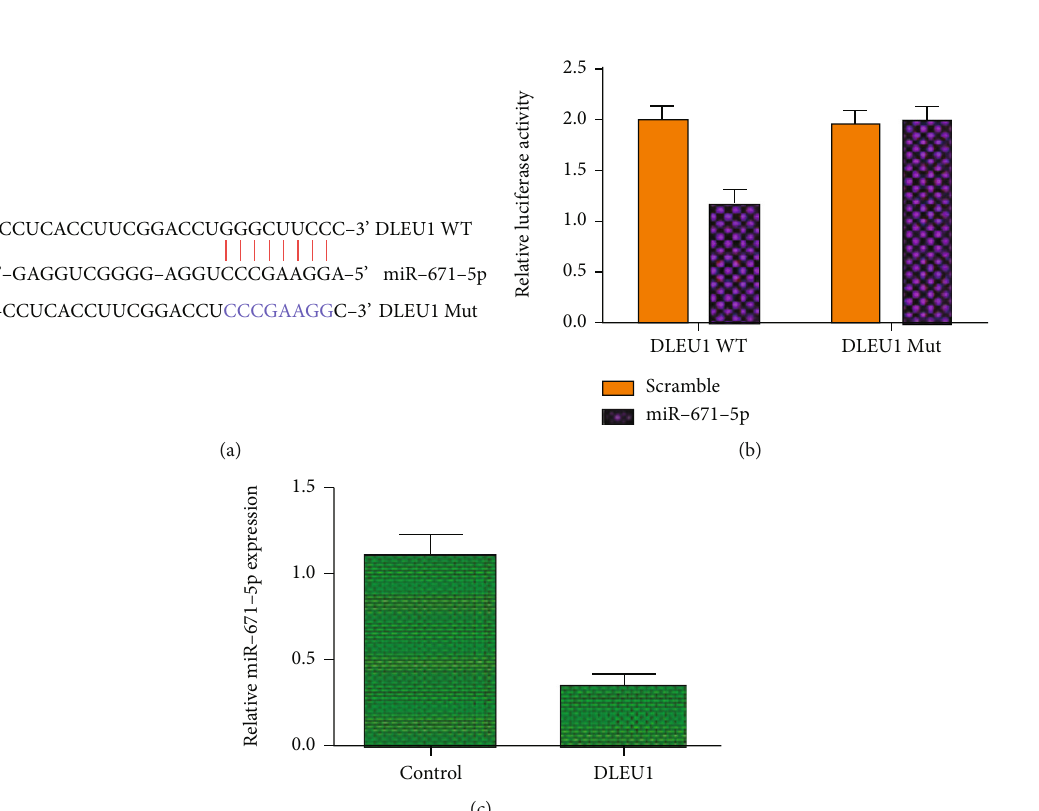
Figure 7: Elevated expression of miR-671-5p suppressed chondrocyte viability, degradation of ECM, and in fl ammation mediator secretion. (a) The expression of miR-671-5p was measured by qRT-PCR analysis. (b) Ectopic expression of miR-671-5p inhibited cell viability in the chondrocytes using CCK-8 assay. (c) Elevated expression of miR-671-5p enhanced collagen II expression in the chondrocytes. (d) The expression of aggrecan was detected by qRT-PCR assay. (e) Overexpression of miR-671-5p suppressed ADAMTS-5 expression in the chondrocytes. (f) The expression of MMP-3 was measured by qRT-PCR assay. (g) miR-671-5p overexpression inhibited IL-6 expression in the chondrocytes using ELISA. (h) The expression of IL-8 was measured by ELISA. (i) The expression of TNF- α was measured by ELISA. ∗ p < 0 : 05 and ∗∗∗ p < 0 : 001 .